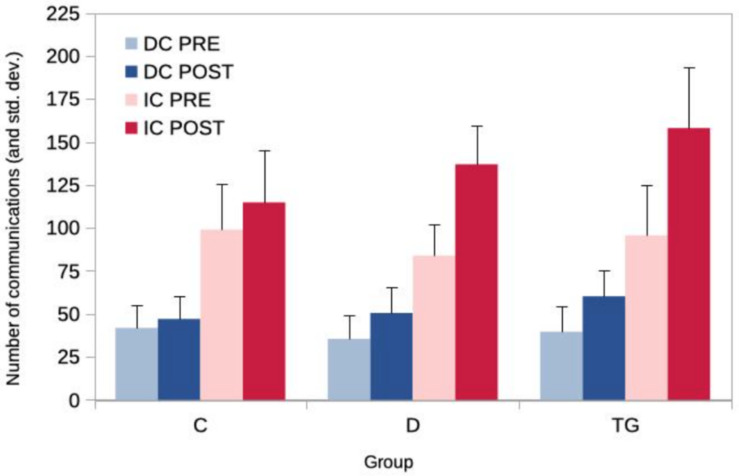
Mean number of direct (DC) and indirect (IC) communications for the PRE and POST measures in the three groups.